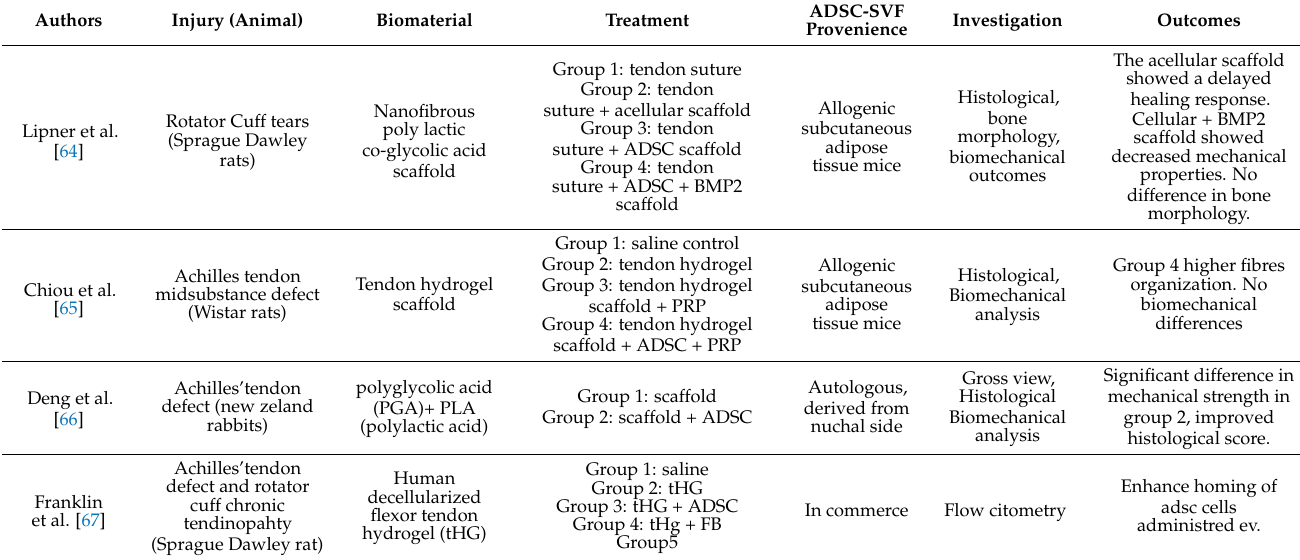
Table 4. Biomaterials and enzymatical/mechanical derived ADSC-SVF in vivo tendinopathy and tendon